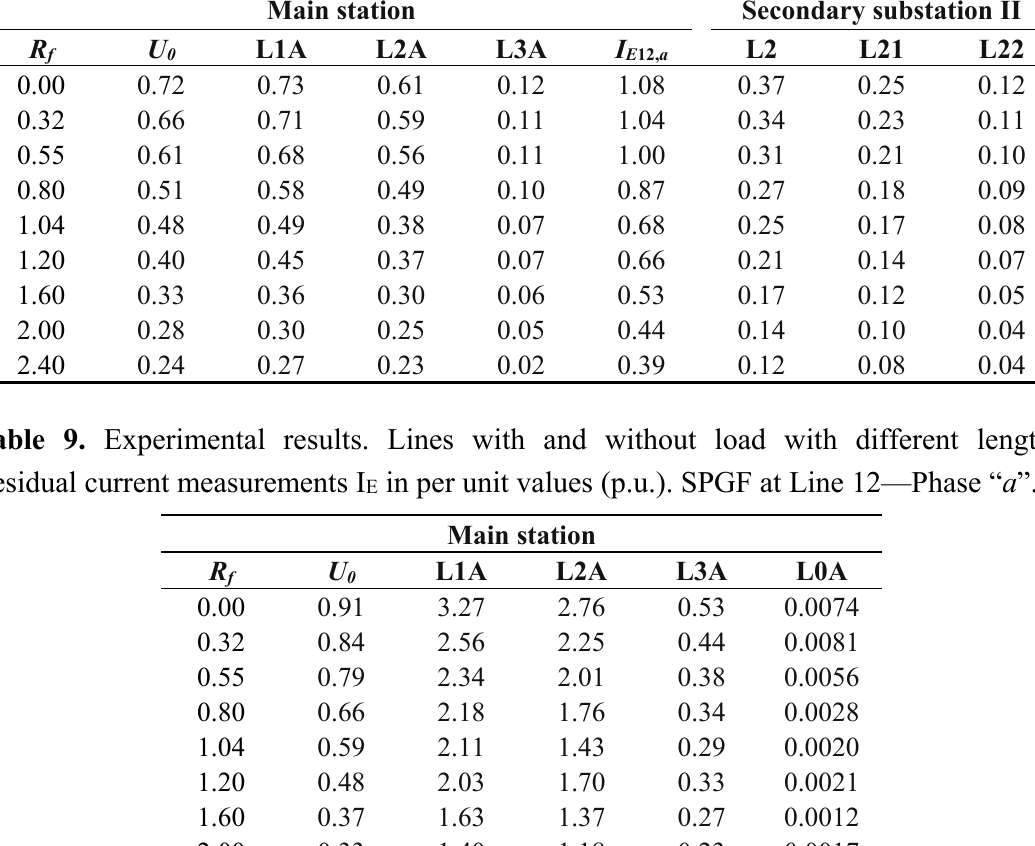
Table 8. Experimental results. Three lines not loaded with different lengths. Residual current